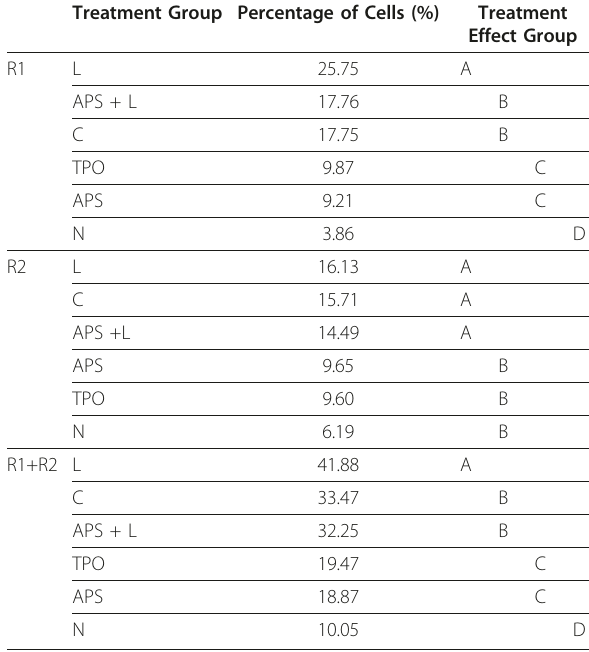
Table 2 Effects of various treatments on the apoptosis of M-07e cells detected by annexin V assay Treatment Group Percentage of Cells (%) Treatment Effect